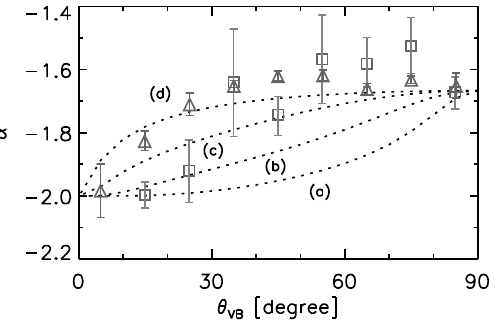
Figure 3. Power-law index α of the one-dimensional streamwise energy spectra as a function of the projection angles from the mean magnetic field θ VB obtained from the non-elliptic anisotropy for four coefficient sets shown in Fig. 1, and that from single-spacecraft measurements of the frequency spectra in the solar wind presented by Horbury et al. (2008) (triangles in gray) and Osman and Horbury (2009) (squares in